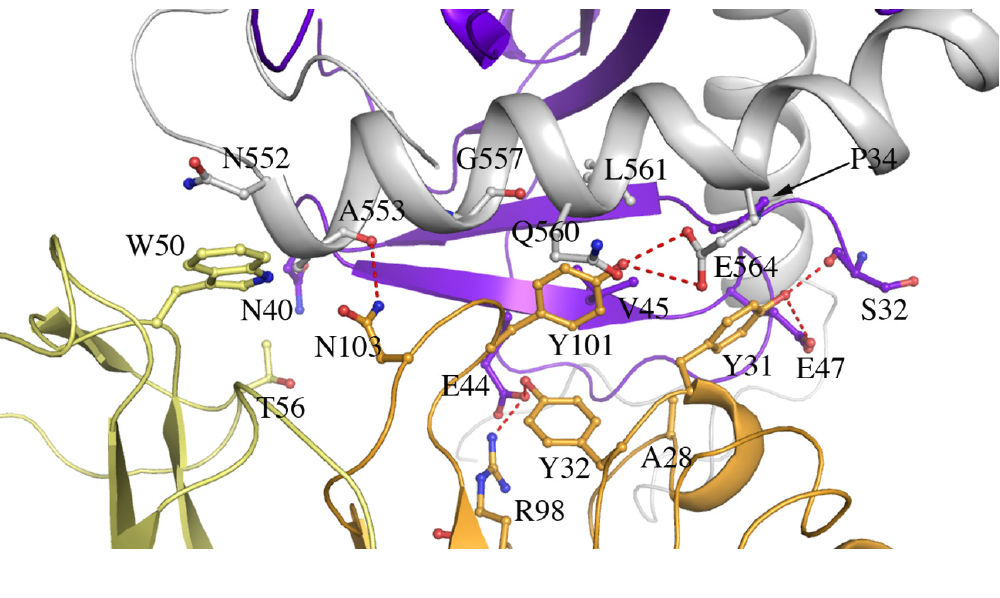
and 16F6 (cutoff distance of 3.5 Figure 4. Residues at the interface of SUDV-Bon GP 1,2 is colored purple, GP is colored white, the 16F6 heavy chain is colored orange Å). GP 1 2 and the light chain is colored pale yellow. Hydrogen bonds are shown as red dashed